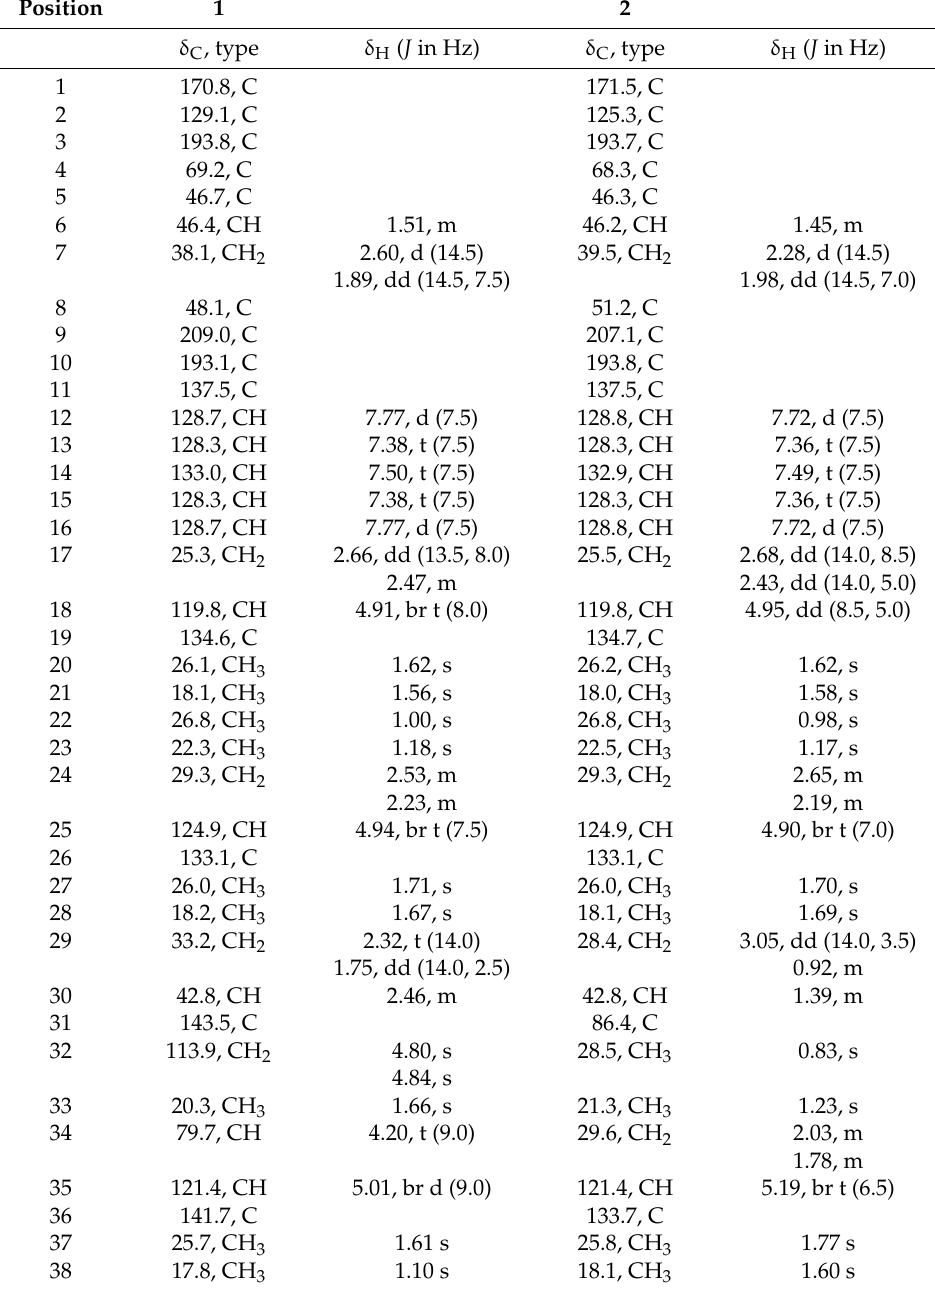
Table 1. 1 H NMR (500 MHz) and 13 C NMR (125 MHz) data for compounds 1 and 2 in CDCl 3